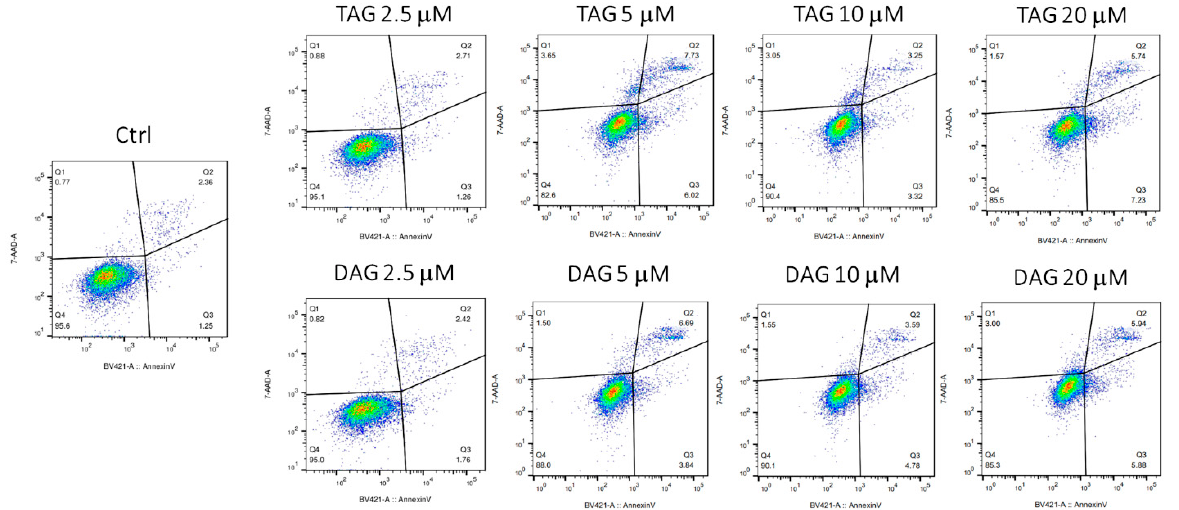
Figure 3. Evaluation of apoptosis in SH-SY5Y cells after the treatment with TAG and DAG molecules at different concentrations (2.5, 5, 10, and 20 μ M) for 24 h in HI-FBS medium. The analysis conducted by FACS through Annexin V/7-AAD cell staining is depicted as a typical flow cytometry dot-plot image.